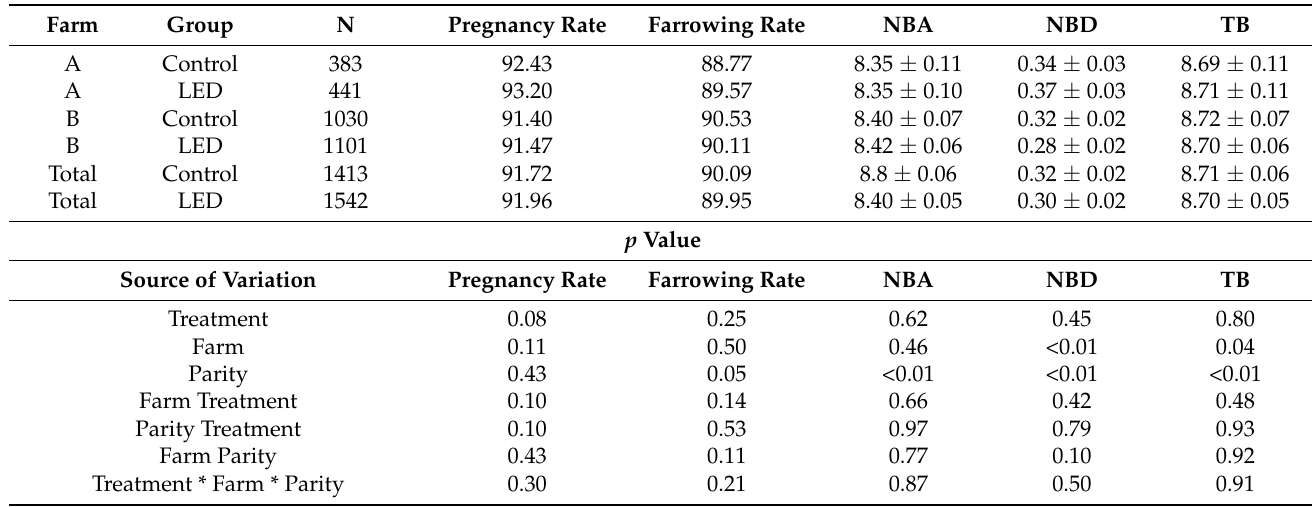
Table 1. Fertility outcomes of sows inseminated with seminal doses after photostimulation by LED or not (control). Data expressed as mean ±